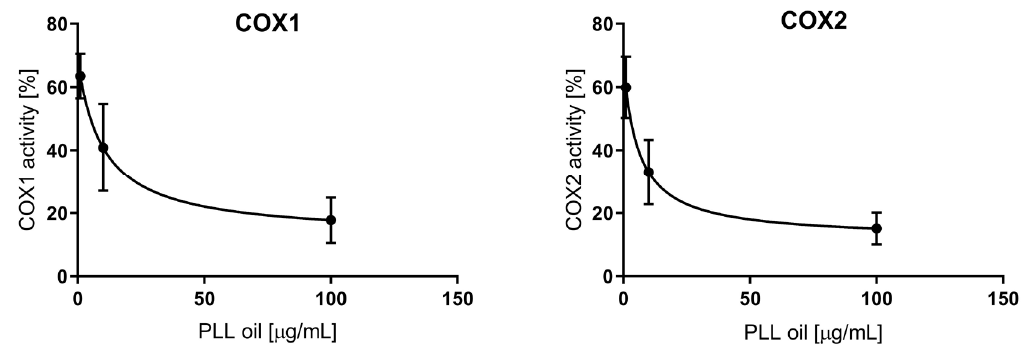
Figure 1. The anti-inflammatory effect of PLL-EO toward cyclooxygenase (COX-1 and COX-2) activity.